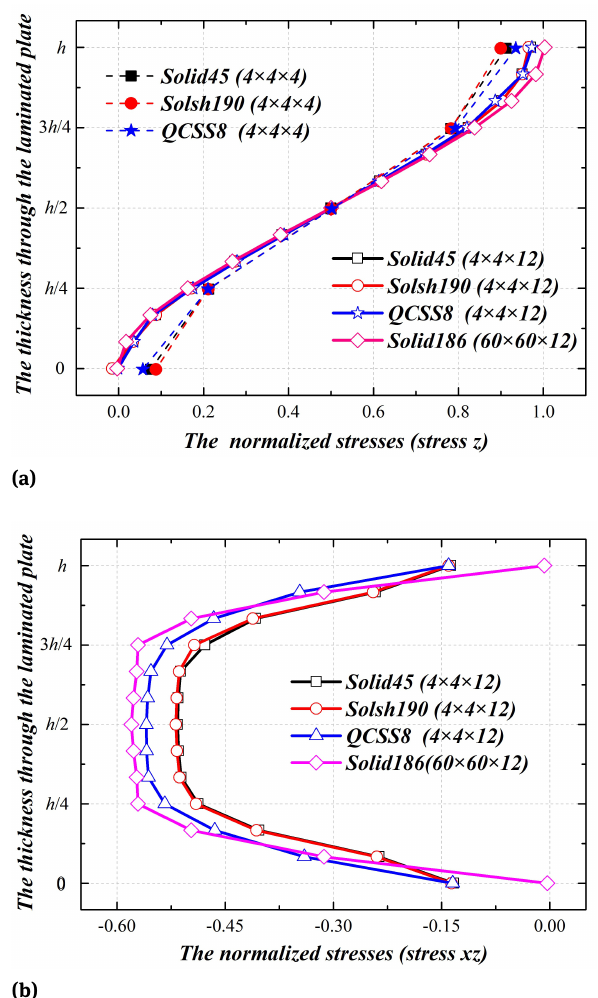
Figure 3: The distribution of the normalized stresses σ z and τ xz through the plate thickness for a simply-supported laminated plate [0/90/90/0] subjected to the uniformly distributed load. ( a / h = 10 ).